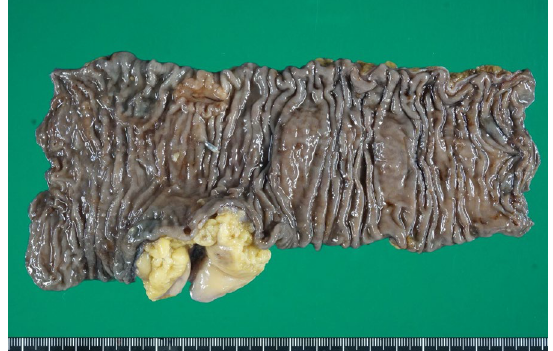
Fig. 5 Macroscopic findings of the primary sigmoid colon cancer. A type-2 tumor (20 16 mm) was seen in the resected sigmoid colon × and